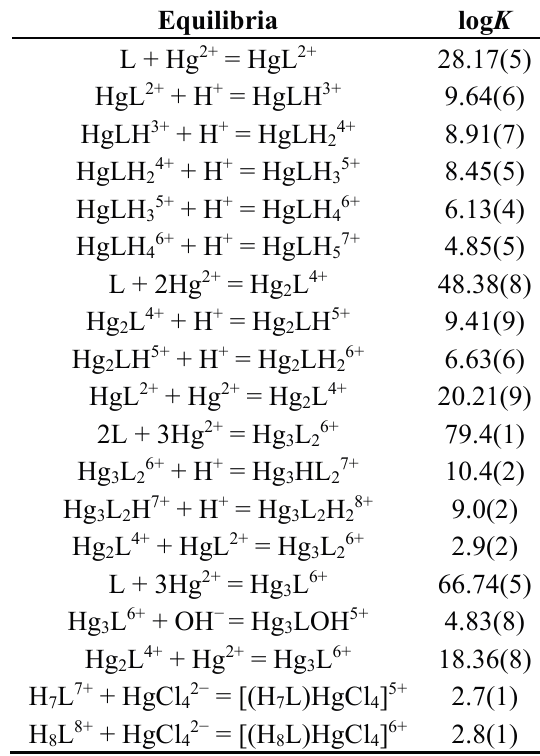
Table 1. Equilibrium constants (with standard deviations in parentheses) for the complexes formed by L with Hg(II) and HgCl 42 − , determined in 0.1 M Me 4 NCl aqueous solution at 298.1